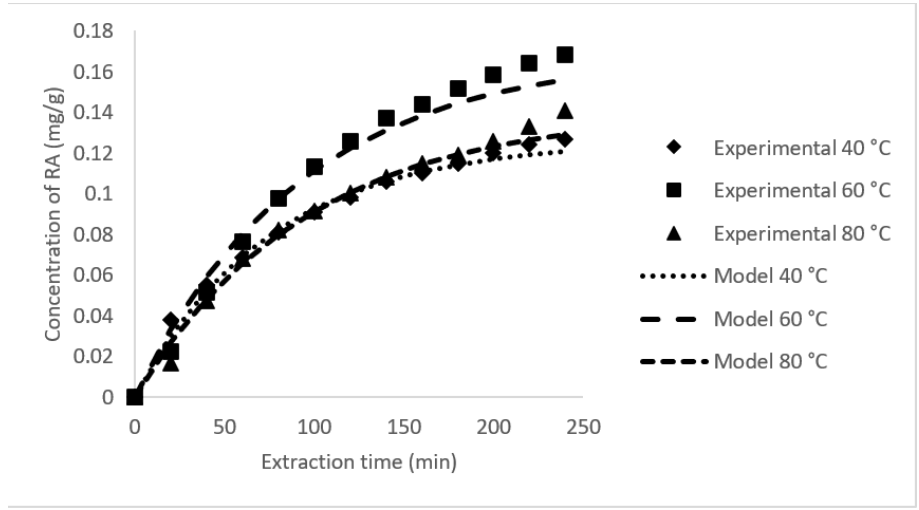
Figure 5. Extraction curve of RA extract from OS at constant pressure of 30 MPa.